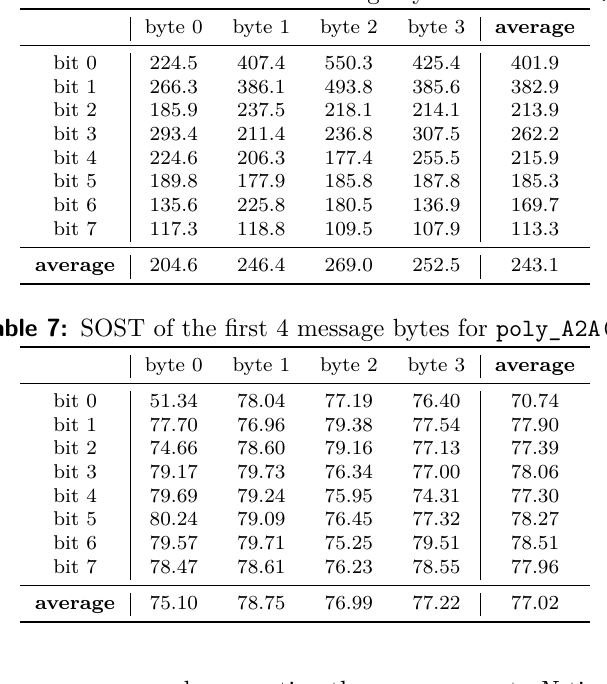
Table 6: SOST of the first 4 message bytes for POL2MSG() .